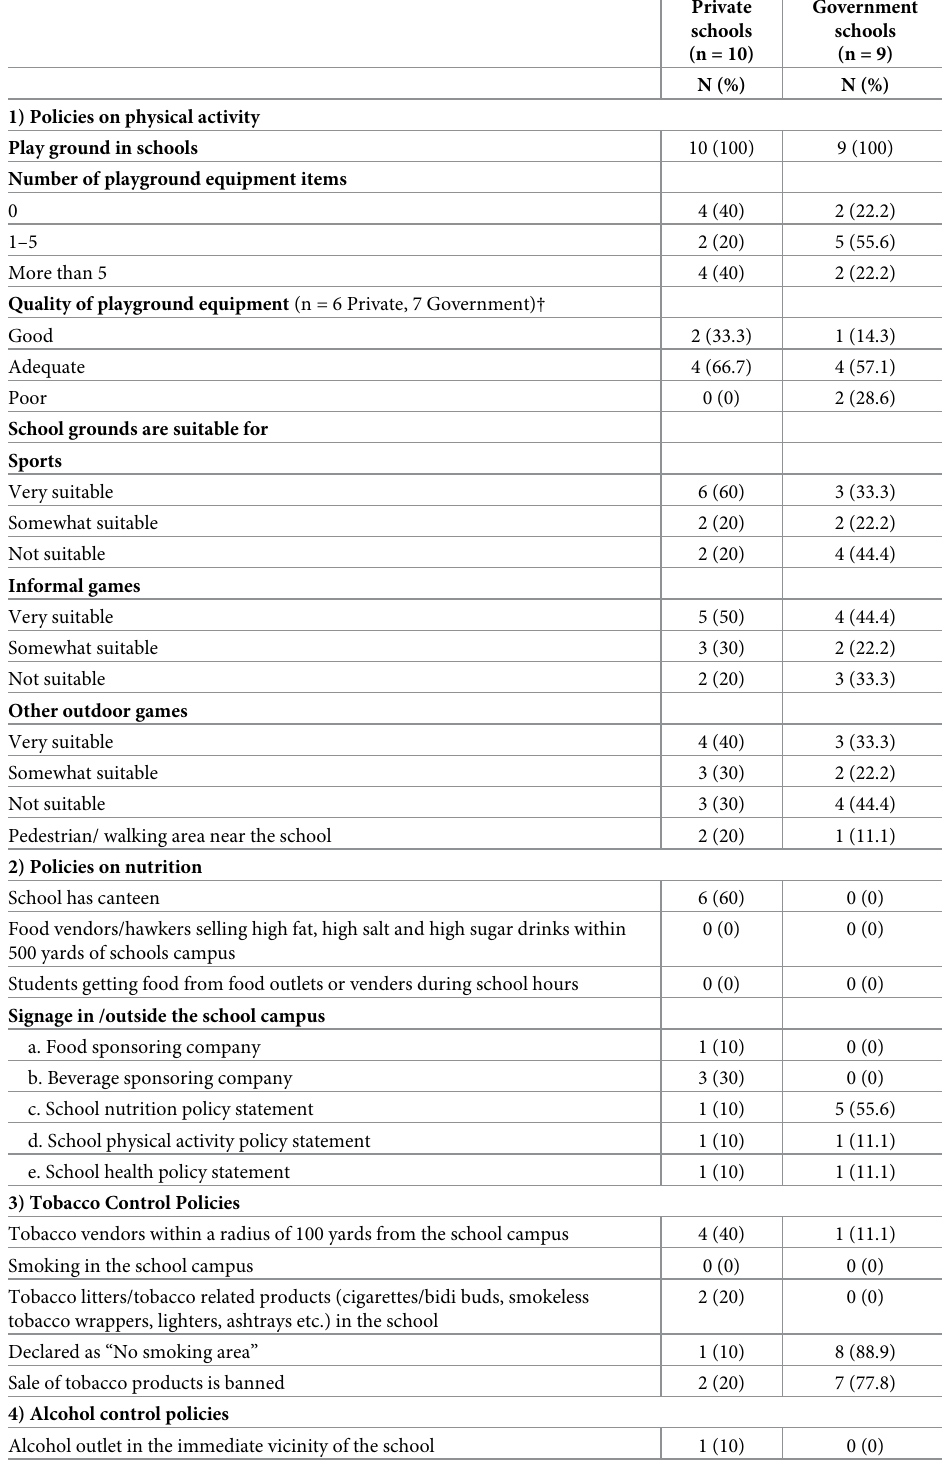
Table 3. Assessment of school built environment in relation to NCD risk factors through structured